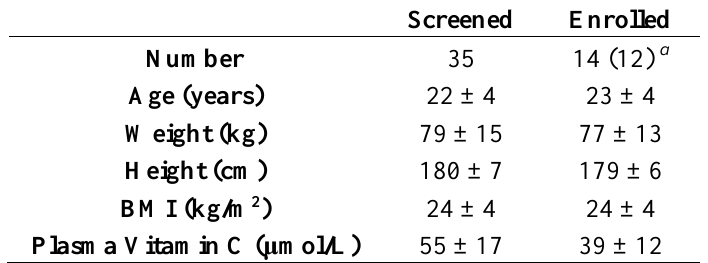
Table 1. Characteristics of individuals enrolled for the study. Data represent mean ±